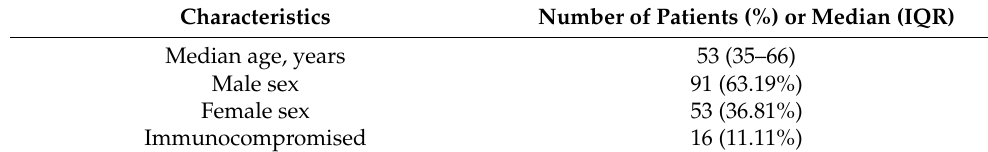
Table 1. Baseline patients’